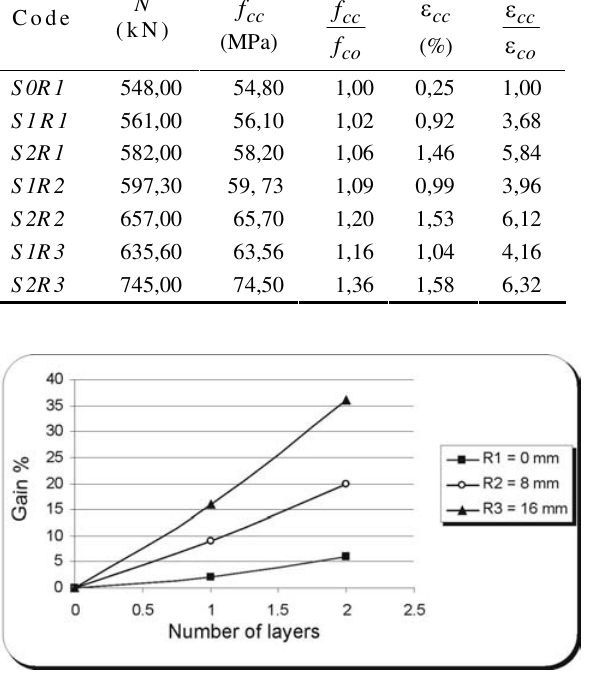
Fig. 4. Gain in compressive strength versus number of layers